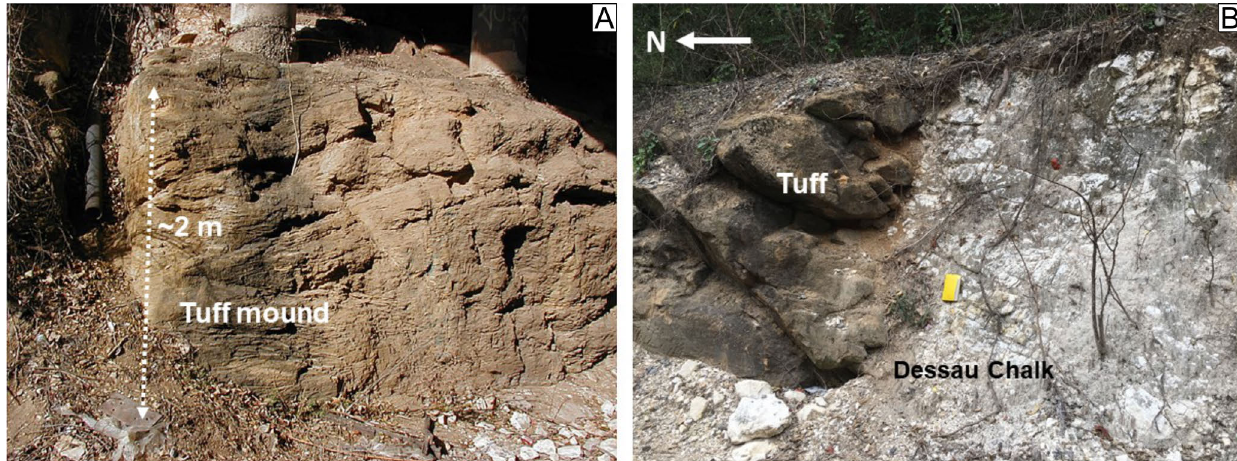
Figure 4: Tu ff mound outcrop beneath the bridge [A] and the contact between Austin Chalk and tu ff units [B] on the west and east faces of the St. Elmo railroad cut,